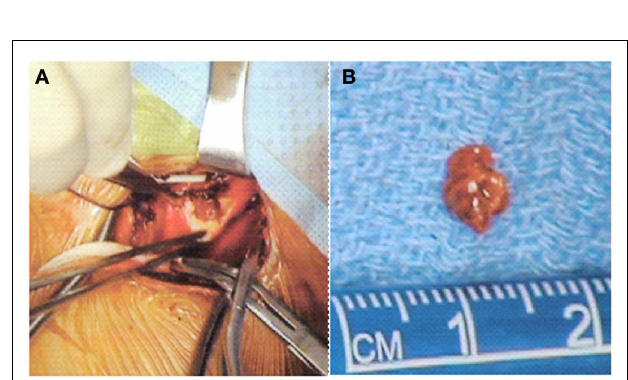
FIGURE 3 | Intra-operative images showing the cervical lesion in situ in the left internal carotid (A) and the 5-mm thrombus after operative thrombectomy (B)